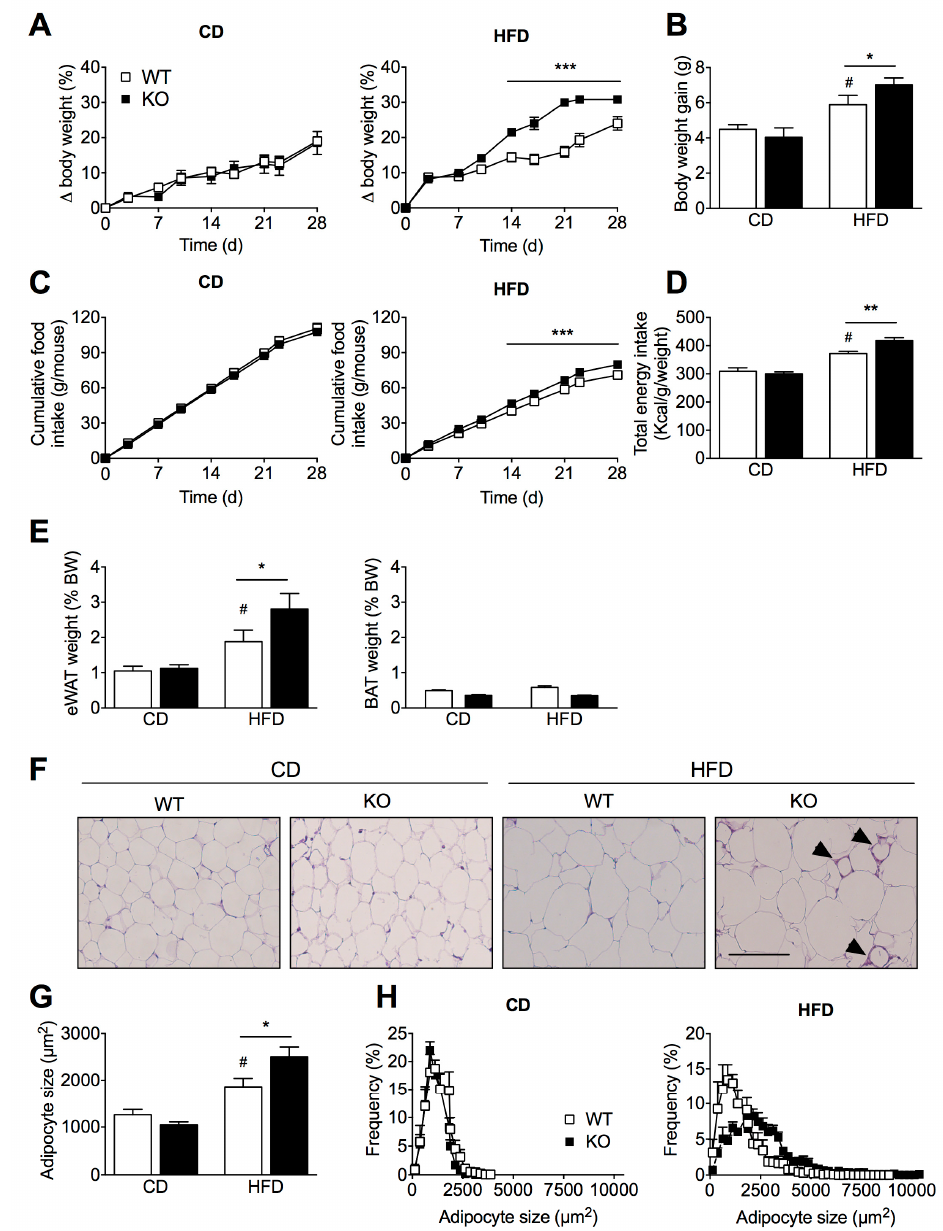
Figure 1. Loss of SIRT2 promotes body weight gain, increased food intake, and adiposity under HFD conditions. ( A ) Body weight gain (%) of WT and SIRT2-KO mice maintained on a CD or a HFD for 4 weeks. ( B ) Total body weight gain (g) at the end of the experiment in WT and SIRT2-KO mice fed a CD or a HFD. ( C ) Cumulative food intake of WT and SIRT2-KO mice on a CD or a HFD. ( D ) Total energy intake (Kcal/weight) calculated at the end of dietary protocol. ( E ) WAT and BAT weight are expressed as a percentage of body weight (BW) of WT and SIRT2-KO mice fed a CD or a HFD. ( F ) Representative images of hematoxylin and eosin (H&E)-stained eWAT sections from WT and SIRT2-KO mice fed a CD or a HFD (scale bar = 100 µ m). Arrows indicate “crown-like” structures. ( G ) Adipocyte size and ( H ) frequency distribution using ImageJ software. Data are presented as mean ± SEM; n = 5 per group; # p < 0.05 compared with CD-fed WT mice; * p < 0.05, ** p < 0.01, *** p < 0.001 compared with HFD-fed WT